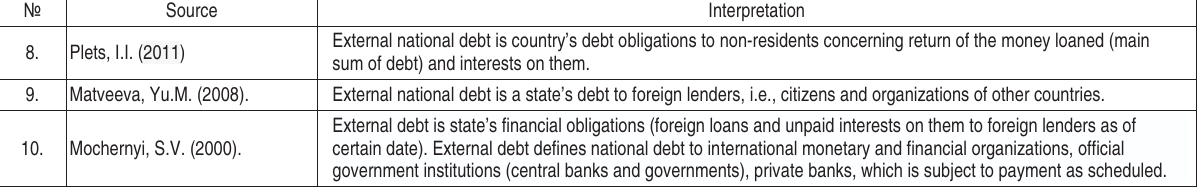
Table 2 (cont.). Scientific and methodical approaches to interpretation of the notion “external national debt”